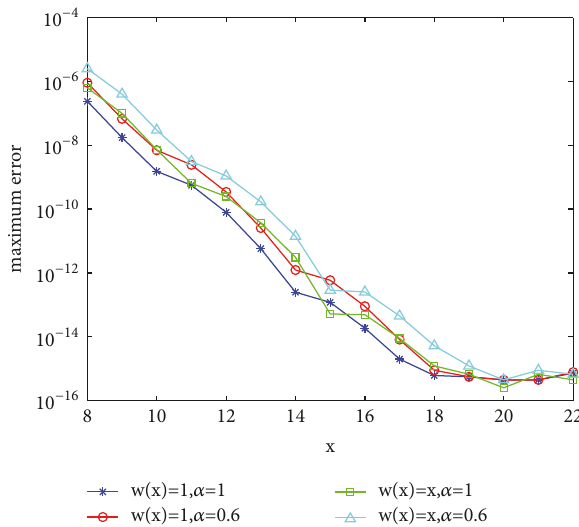
Figure 3: Approximation error of Hadamard fractional integral for different weight 𝑤 and 𝛼